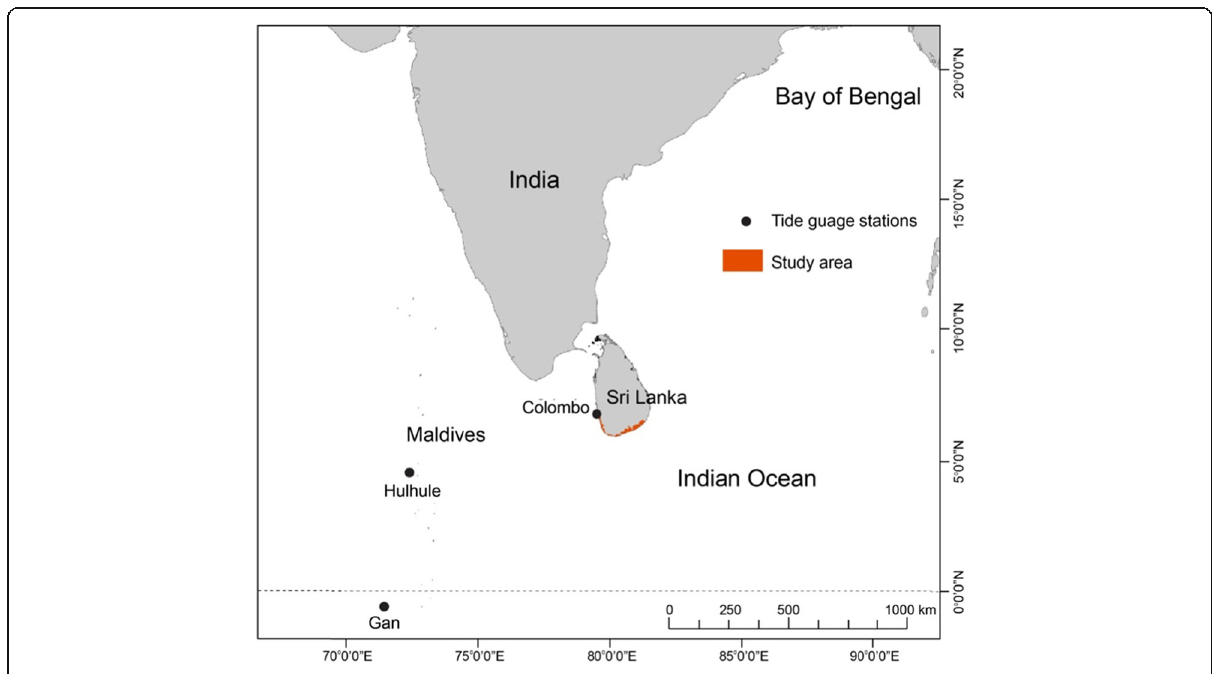
Fig. 1 Location of the study area in the central Indian Ocean